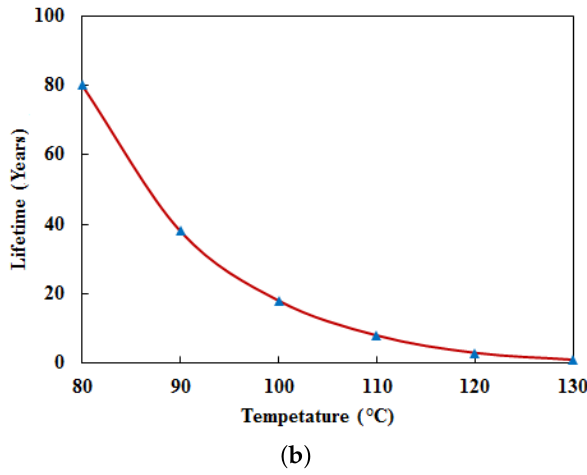
Figure 1. ( a ) Threshold voltage variation of PMOS transistor at at stress time of 10 5 s [15,16] ( b ) Change in life time with the temperature [14].